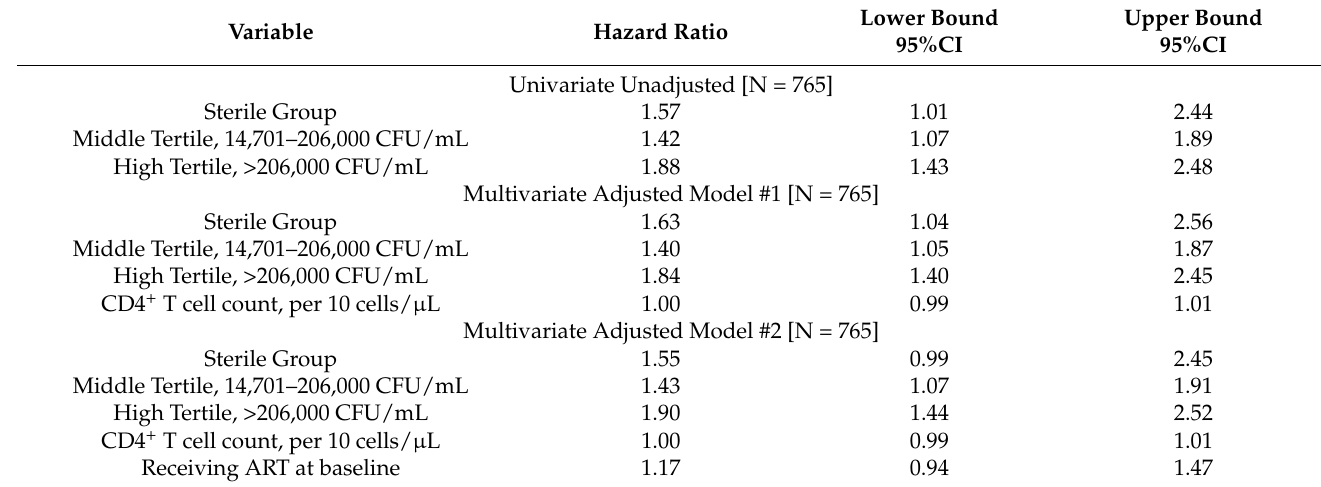
Table 2. Proportional Hazards Regression Models for 18 Week Mortality by CSF Quantitative